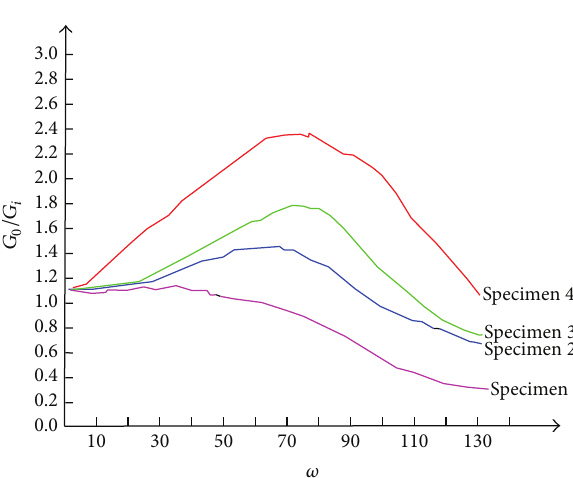
Figure 6: Relationship between 𝐺 0 /𝐺 𝑖 and kinking angle 𝜔